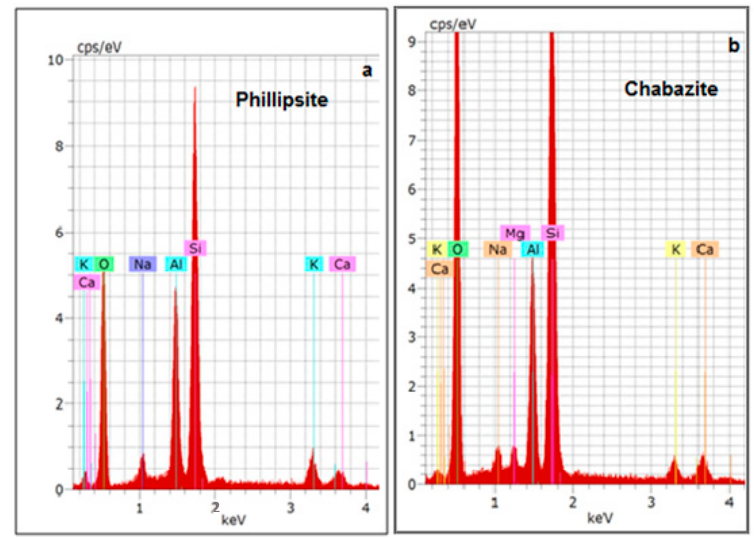
Figure 3. Energy dispersive X-ray spectra: ( a ) Na-, K-, Ca-phillipsite and ( b ) Na-, Mg-, K-, Ca-chabazite crystals.